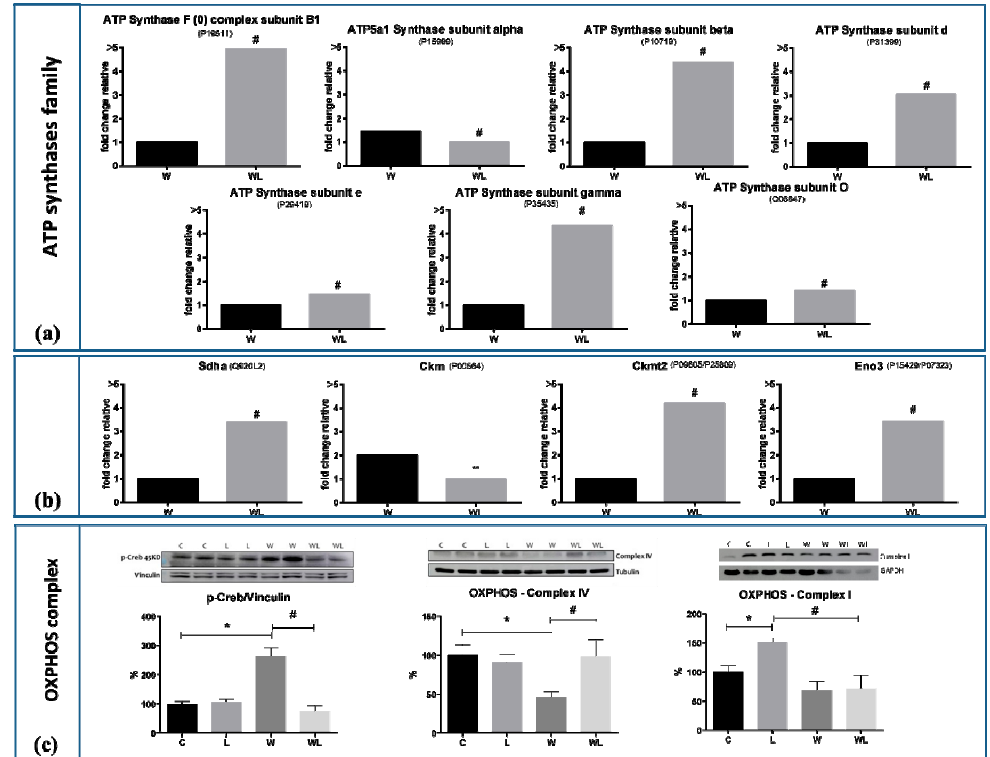
Figure 6. Muscle mitochondrial proteins of all experimental groups subject or not to leucine-rich diet and bearing or not Walker-256 tumour. ( a ) ATP Synthases family: average concentrations of the ATP synthase complex subunit B1 (accession code P19511), subunit alpha (accession code P15999), subunit beta (accession code P10719), subunit d (accession code P31399), subunit e (accession code P29419), subunit gamma (accession code P35435) and subunit O (accession code Q06647). ( b ) Succinate dehydrogenase [ubiquinone] flavoprotein subunit—Sdha (accession code Q920L2); Creatine Kinase M-type, cytoplasmic—Ckm (accession code P00564); Creatine Kinase S-Type, mitochondrial—Ckmt2 (accession code P09605/P25809); Beta-Enolase—Eno3 (accession code P15429/P07323). ( c ) OXPHOS proteins of Western blot assay: Protein CREB phosphorylated (p-Creb: 43 kDa; loading control vinculin 124 kDa), OXPHOS—Complex IV (40 kDa; loading control tubulin 55 kDa) and OXPHOS—Complex I (20 kDa; loading control GAPDH 37 kDA) in gastrocnemius muscle. Western blot images represent the representative from each group. Legend: C, control group; W, Walker tumour-bearing group; L, rats fed a leucine-rich diet; WL, tumour-bearing rats fed a leucine-rich diet. * p < 0.05 difference against C group; ** p < 0.05 difference against L group: # p < 0.05 difference against WF group. Detailed information about Western blot can be found at Figure S1.